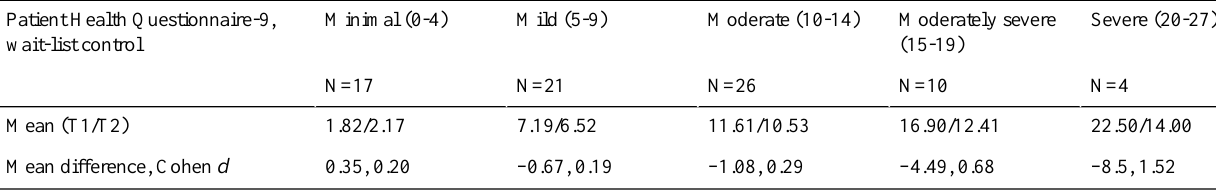
Table 6. Analysis of Patient Health Questionnaire-9 subgroups: control.